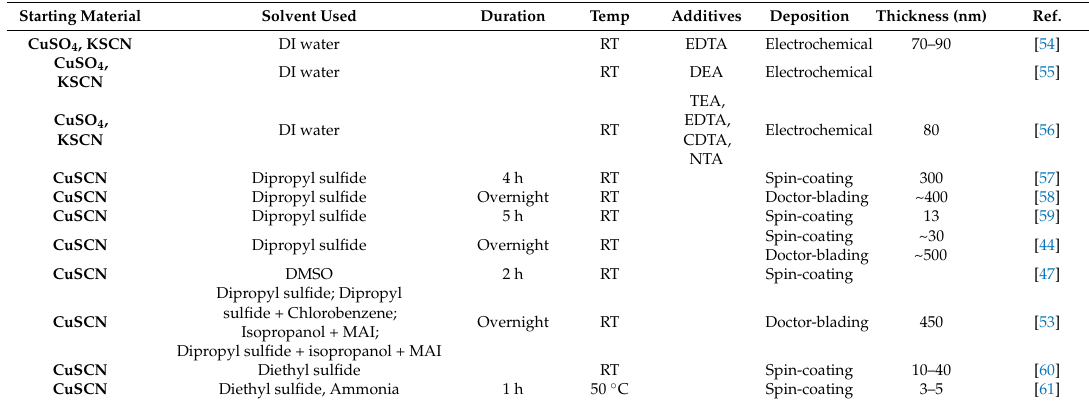
Table 2. Fabrication of CuSCN films using different starting material and